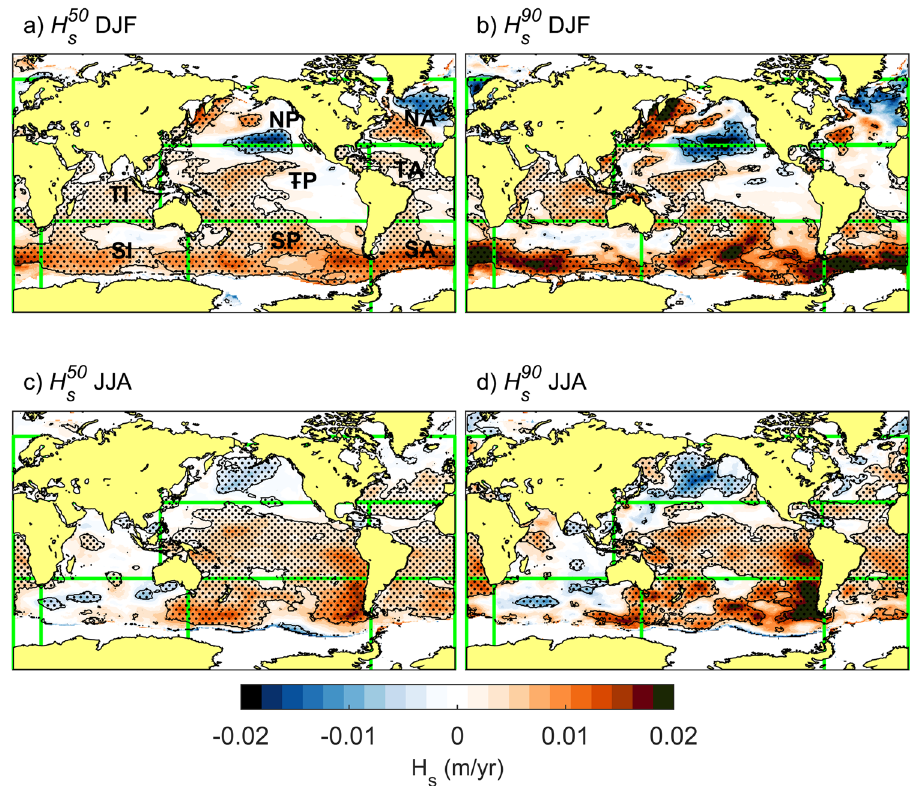
Fig. 4 Signi fi cant wave height ( H s ) trends based on the 7-member ensemble for 1980 – 2014. a Median DJF season, b 90th percentile DJF, c median JJA season, and d 90th percentile JJA. Stippling indicates regions of robust trends (multi-member ensemble mean> inter-member standard deviation; see Methods). Green lines delineate large-scale ocean basins (NP: North Paci fi c; NA: North Atlantic; SP: South Paci fi c; SA: South Atlantic; SI: South Indian; TP: Tropical Paci fi c; TA: Tropical Atlantic; TI: Tropical